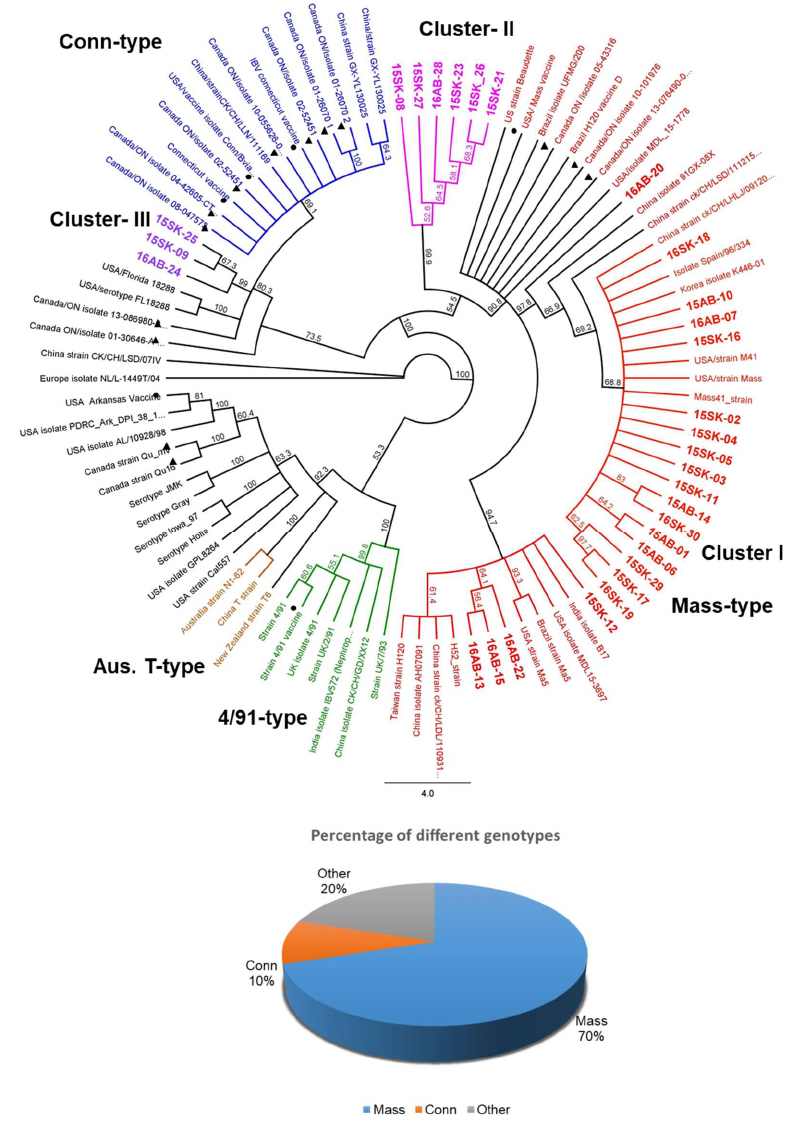
Figure 1. Nucleotide phylogenetic tree of IBV S1 . Maximum likelihood phylogenetic tree inferred based on the 508-nucleotide fragment of the S1 nucleotide sequence. The resulting cladogram of the 30 strains of this study including 64 reference sequences is shown along with bootstrap values (current study isolates in bold; vaccine reference strains are marked with ●; previous Canadian strains are marked with ▲ ; IBV reference clusters and sub-clusters are color-coded). Scale bar indicates the percentage of sites changing along each branch. The pie chart shows the percentage of current IBV strains, which represent each genotype.